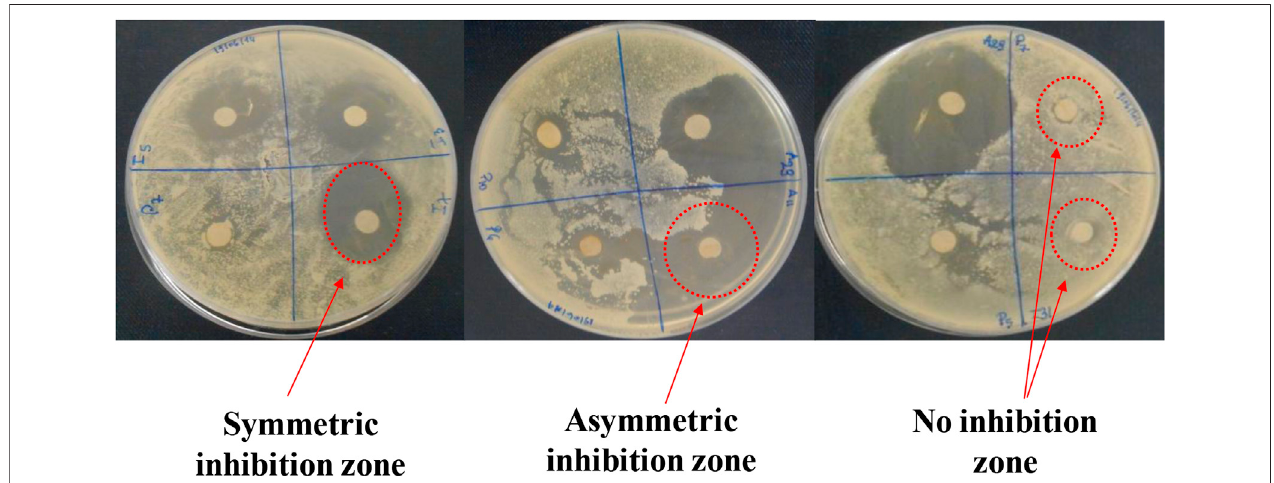
FIGURE 1 | (A) Symmetric inhibition ([C 4 mim + ][PF 6 − ]), (B) asymmetric inhibition ([N 8,8,8,1 + ] [NTf 2 − ]), and (C) no inhibition zone ([C 2 mim + ] [NTf 2 − ]) in the agar diffusion test.